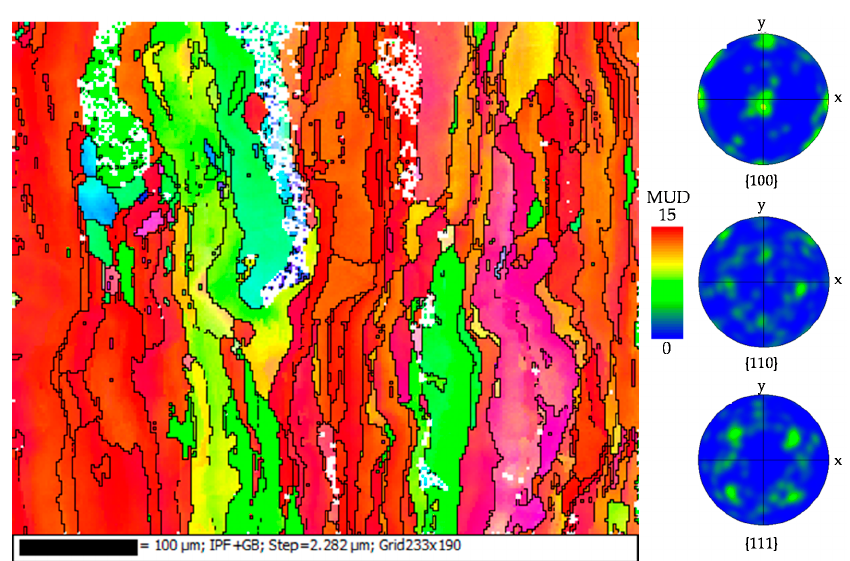
Figure A1. EBSD picture and pole figures for P L = 133 W, v s = 80 mm/s, Δ y = 60 µm, T pre = 0 °C. Materials 2019 , 12 , x FOR PEER REVIEW